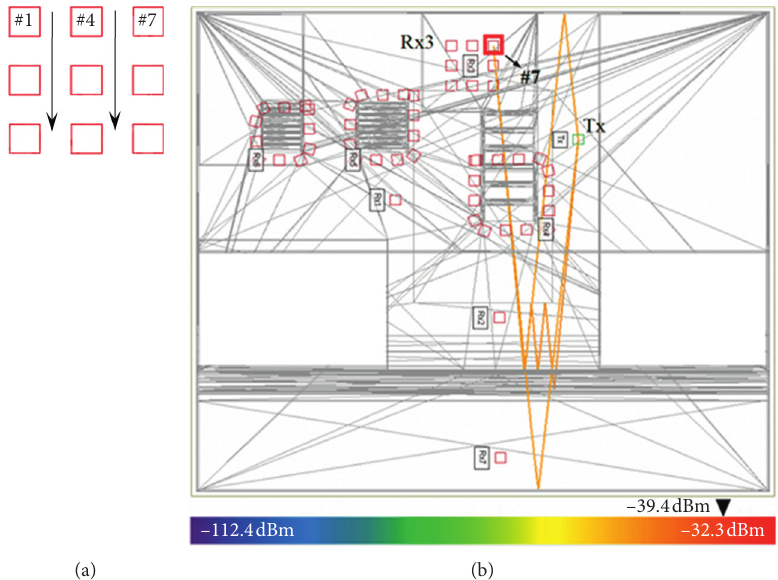
Figure 5: Simulated results of the Rx3 receiver. (a) Node deployment of Rx3. (b) Three paths with the strongest signal strength of